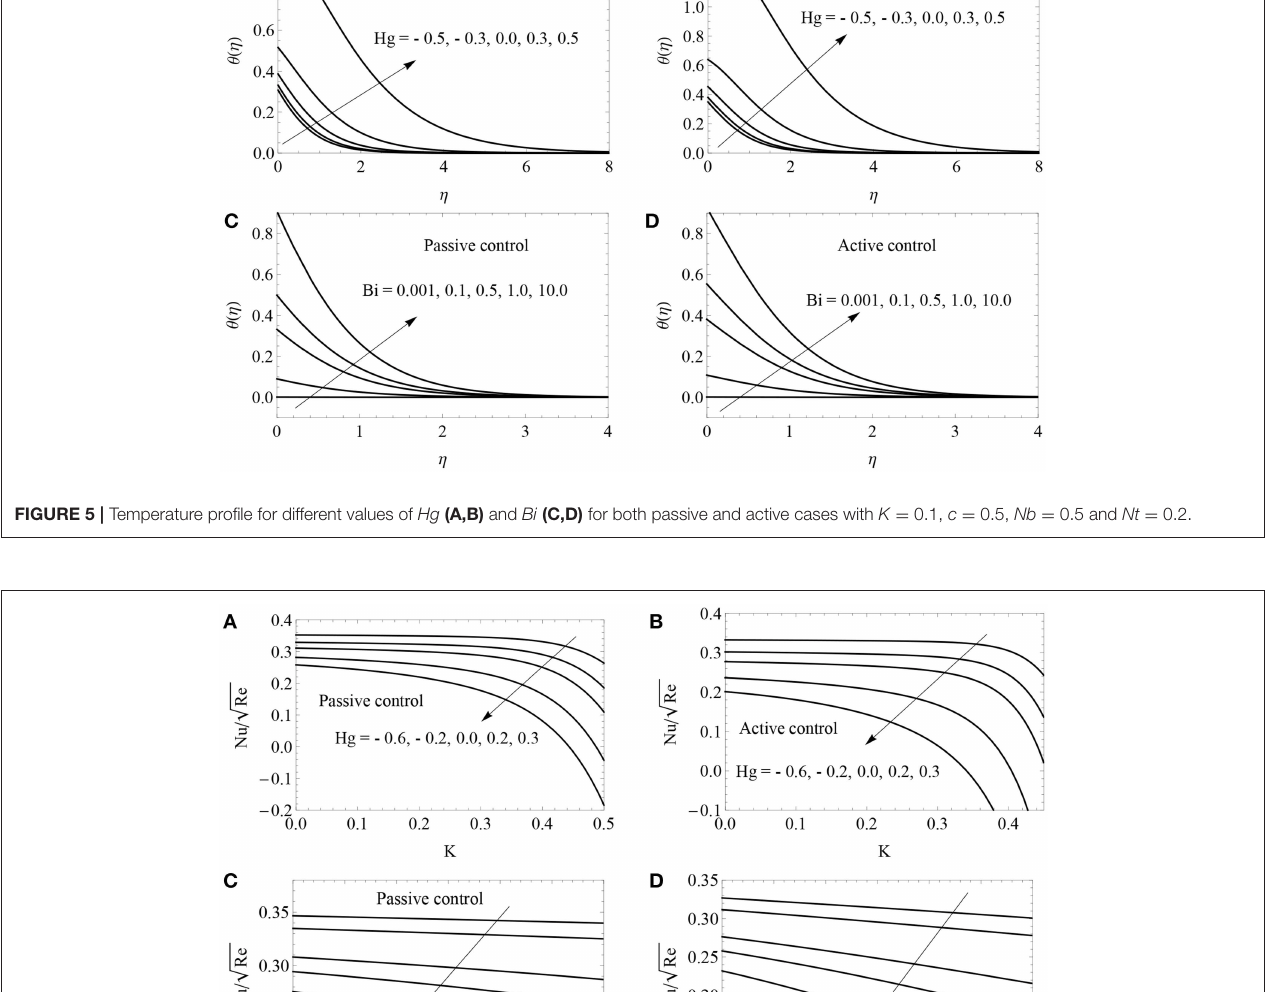
FIGURE 6 | Local Nusselt number for different combination of Hg , K (A,B) and Nt (C,D) with K